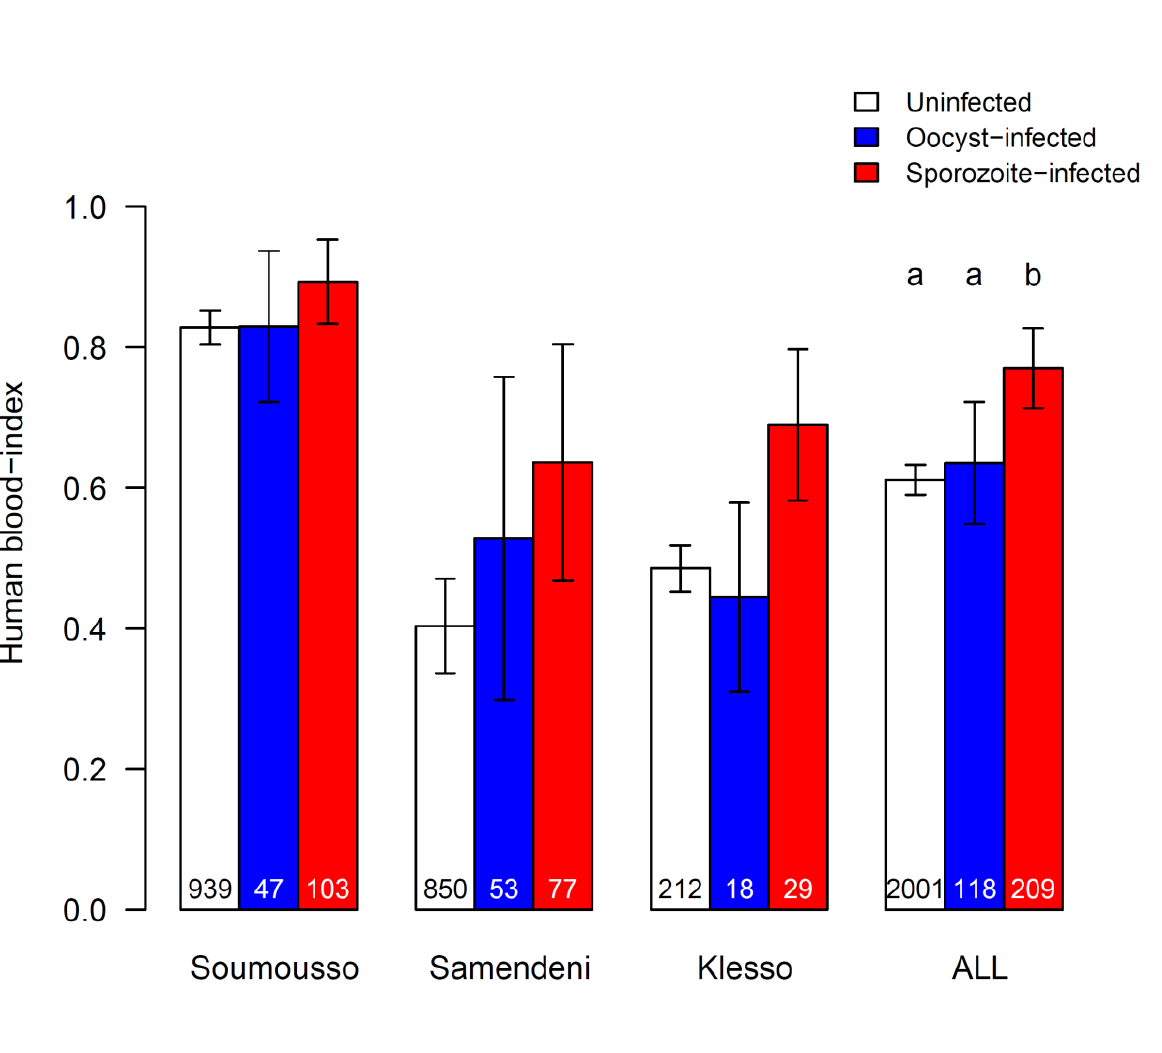
Figure 2. Effect of infection status on the human-blood index of Anopheles gambiae s. l . females expressed as the number of females fed on humans out of the total number of blood-fed females for the three sampled villages. Data show proportion ± 95% confidence intervals. Numbers in bars indicate the total numbers of mosquitoes. Different letters indicate differences between infection status (Chi-square post-hoc tests: sporozoite-infected vs . oocyst-infected females X 2 1 =6.1, P=0.013; sporozoite-infected vs . uninfected females X 2 1 =19.4, P<0.0001; oocyst-infected vs . uninfected females X 2 1 =0.18, P= 0.67).